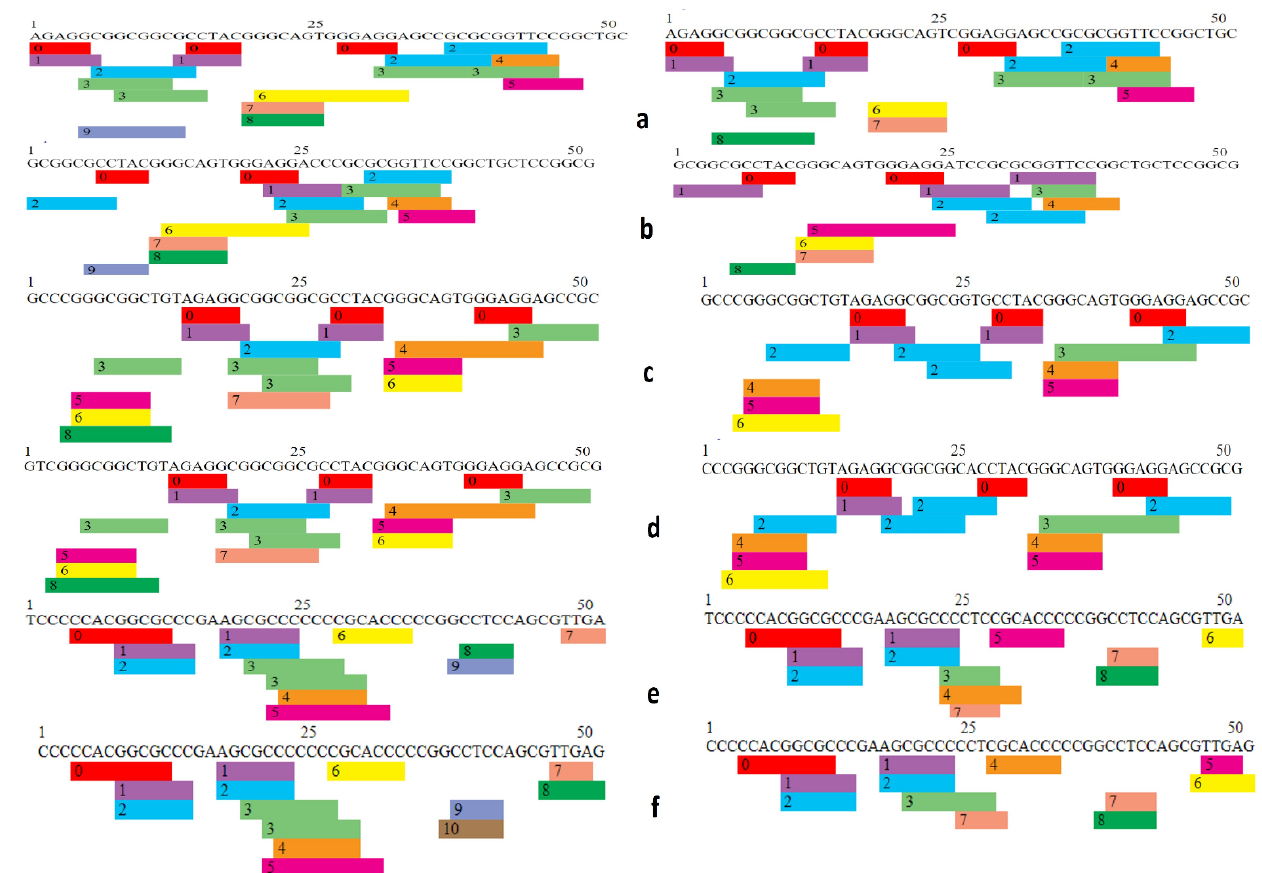
Figure 6. Comparison of transcription factor binding sites of wild and mutated sequences: ( a ) rs994884642: the wild sequence has 9 transcription factors in total while the mutant has 8 TBFS; ( b ) rs1482898617: the wild type (WT) has 9 while Mutant type (MT) has 8; ( c ) in rs1024270582 WT, TBFS are 8 while in MT the number is 6; ( d ) for TBFS in rs1031689697 WT, there are 9 TFBS, there are, while in MT there are 6; ( e ) for rs1366285245 WT the TBFS are 9 and for MT TBFS are 8; ( f ) the WT of rs111868479 contain 10 TBFS and in MT the number is reduced to 8.